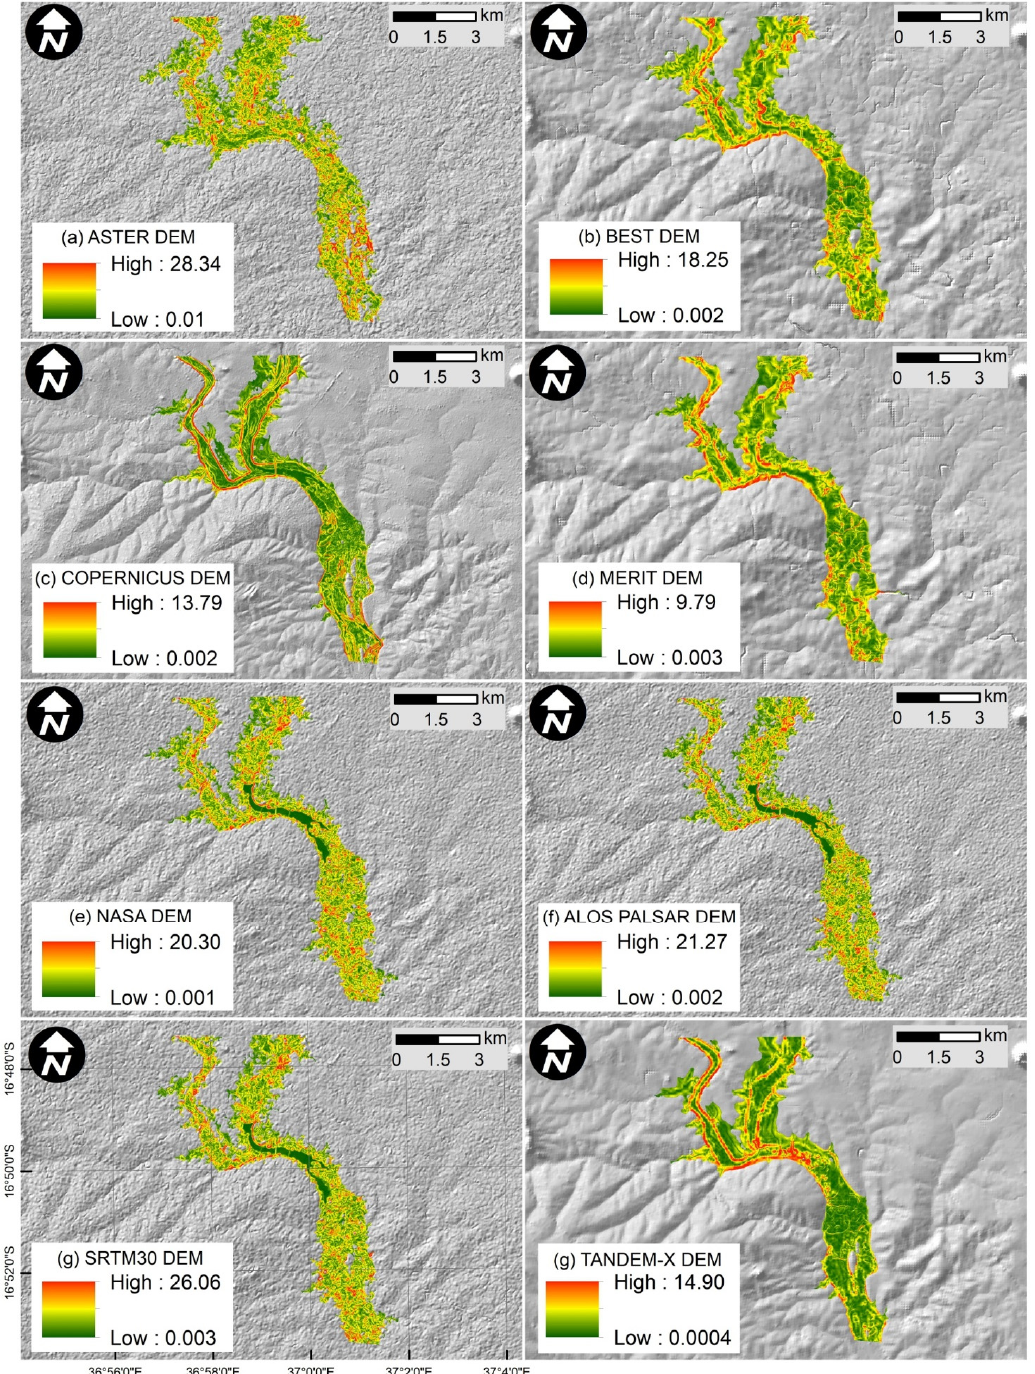
Figure 7. Water surface slope results for the January 2015 flooding event in each one of the free global DEMs used, where the peak flow data used (18,000 m 3 s − 1 ) comes from previous reports [52].